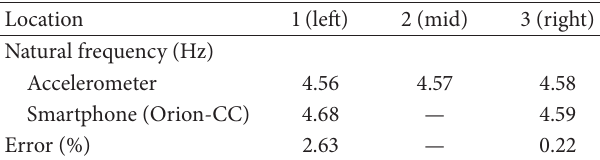
Table 7: Comparison of natural frequency identified from angle